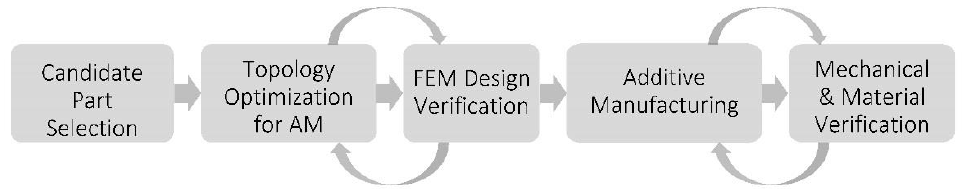
Figure 2. Holistic Process Flow for the fabrication of repeatable AM components.